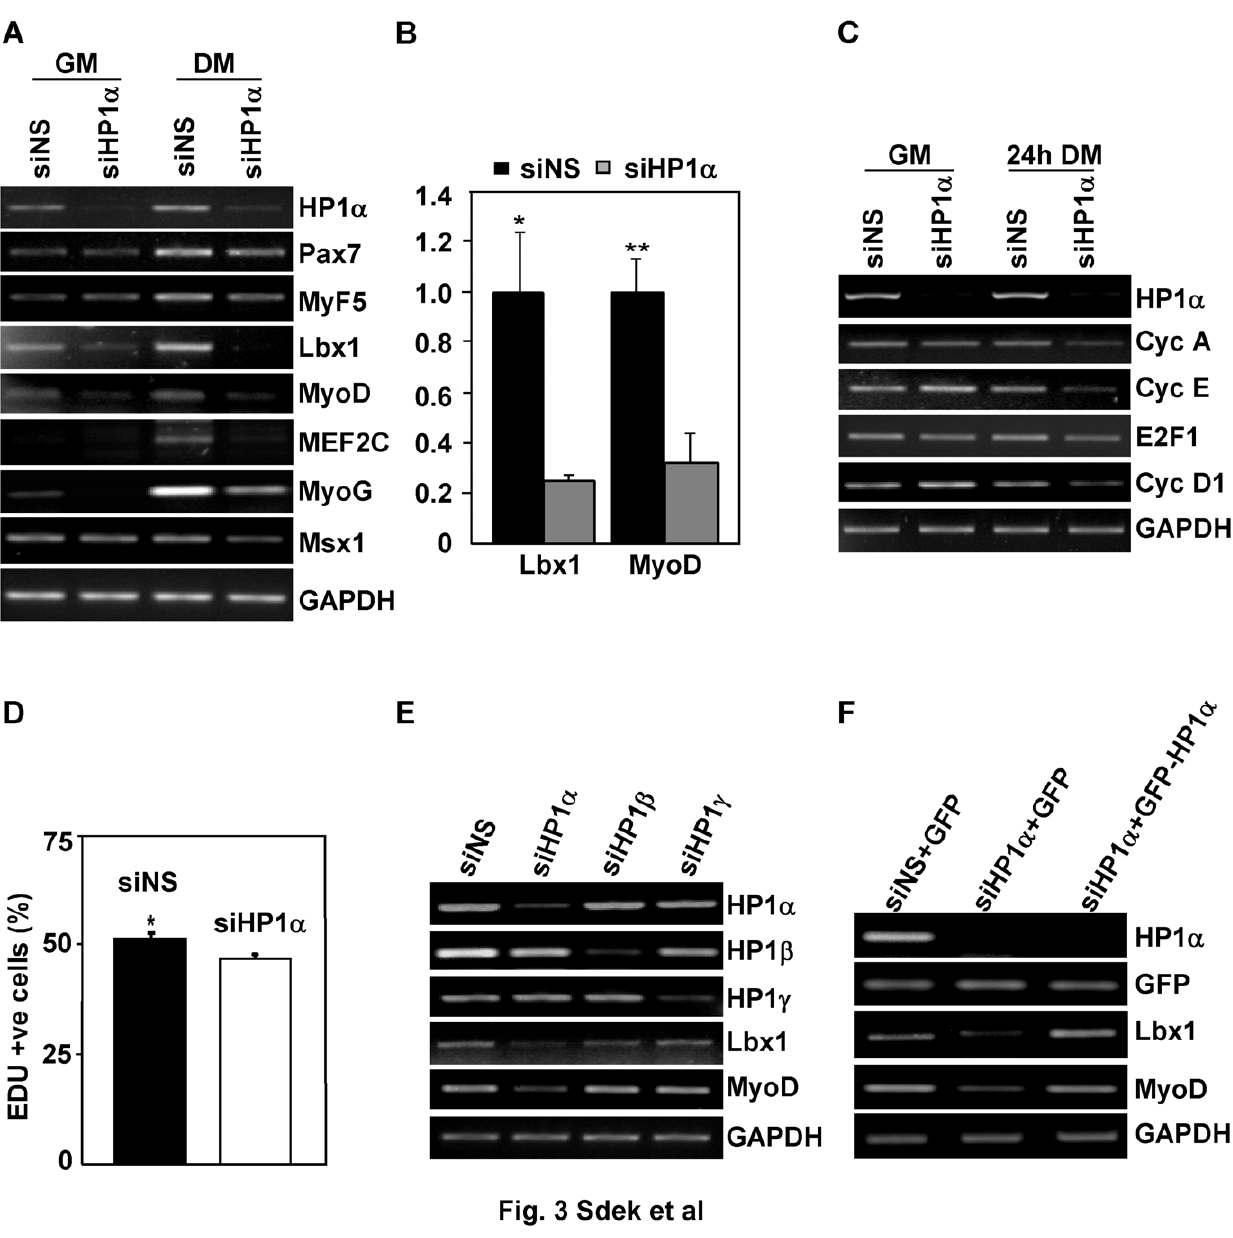
Figure 3. HP1 a -deficient myocytes demonstrate a defect at the committed myoblast stage with reduced Lbx and MyoD expression. A, B, C. C2C12 myoblasts were transfected with indicated siRNA. 24 hours after transfection, transfection medium were changed to GM or DM,